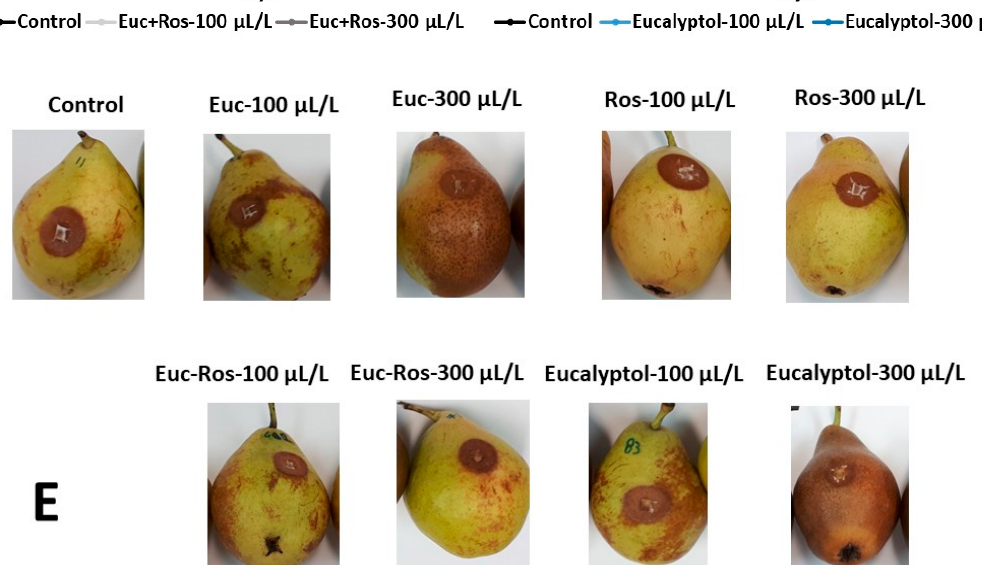
Figure 5. Effects of ( A ) eucalyptus EO (Euc), ( B ) rosemary EO (Ros), ( C ) their 50:50 mixture (Euc + Ros) and ( D ) eucalyptol on lesion growth of P. expansum grown on pear fruits stored at 7 °C for 5 days and subsequently at RT up to 15 days. Significant differences ( p < 0.05) among treatments are represented with different Latin letters; ns indicates no significant differences among the treatments, on the last day. ( E ) Representative image is also presented.